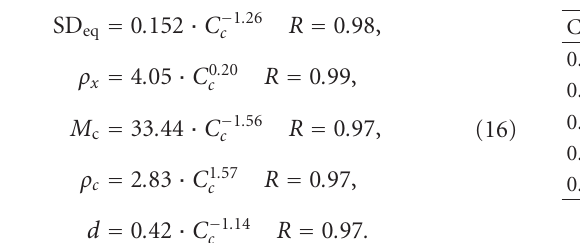
Table 3: E ff ect of changes in Cc on primary structural parameters of PMA